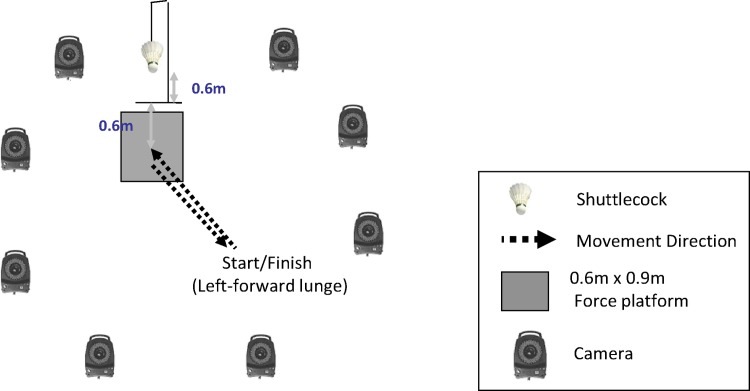
Experimental setup.